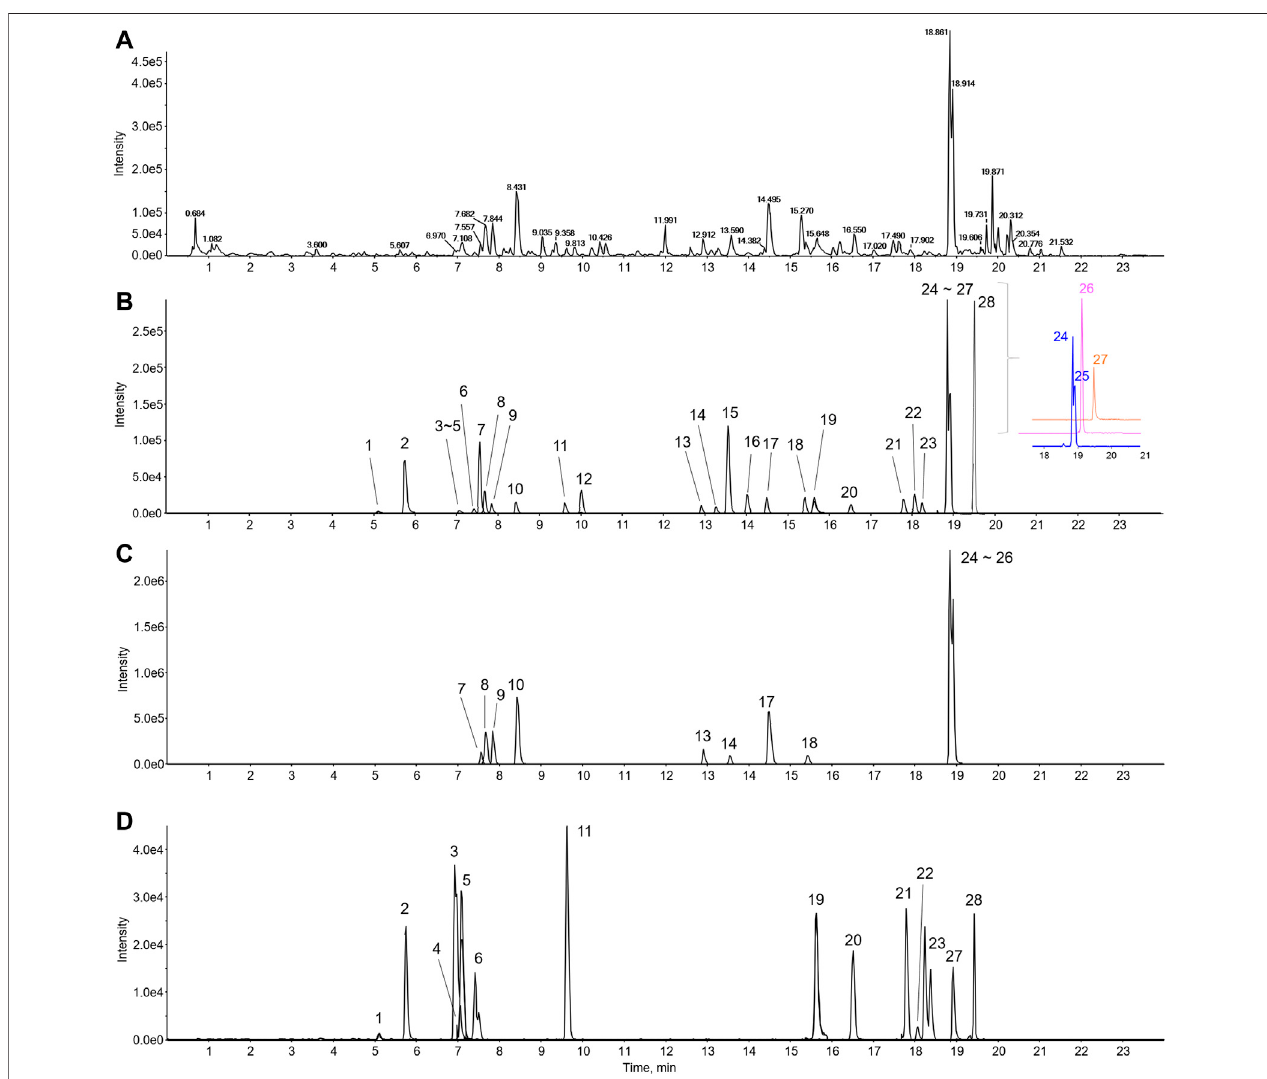
FIGURE1| LC-MS/MSchromatogramofBJIKT.TherepresentativebasepeakchromatogramoftheBJIKTextract (A) andtheextractedionchromatogramsof28 reference standards (B) and sample (C – D) were obtained using LC-ESI-MS/MS analysis in positive ion mode. 1: caffeic acid, 2: magno fl orine, 3: ferulic acid, 4: liquiritin apioside, 5: liquiritin, 6: isoferulic acid, 7: cimifugin, 8: nodakenin, 9: narirutin, 10: hesperidin, 11: ginsenoside Rg1, 12: liquiritigenin, 13: ginsenoside Rb1, 14: saikosaponin C, 15: formononetin, 16: astragaloside IV, 17: glycyrrhizin, 18: saikosaponin A, 19: 6-gingerol, 20: atractylenolide III, 21: astragaloside I, 22: saikosaponin D, 23: ginsenoside Rg3, 24: decursin, 25: decursinol angelate, 26: atractylenolide II, 27: 6-shogaol, and 28: atractylenolide I